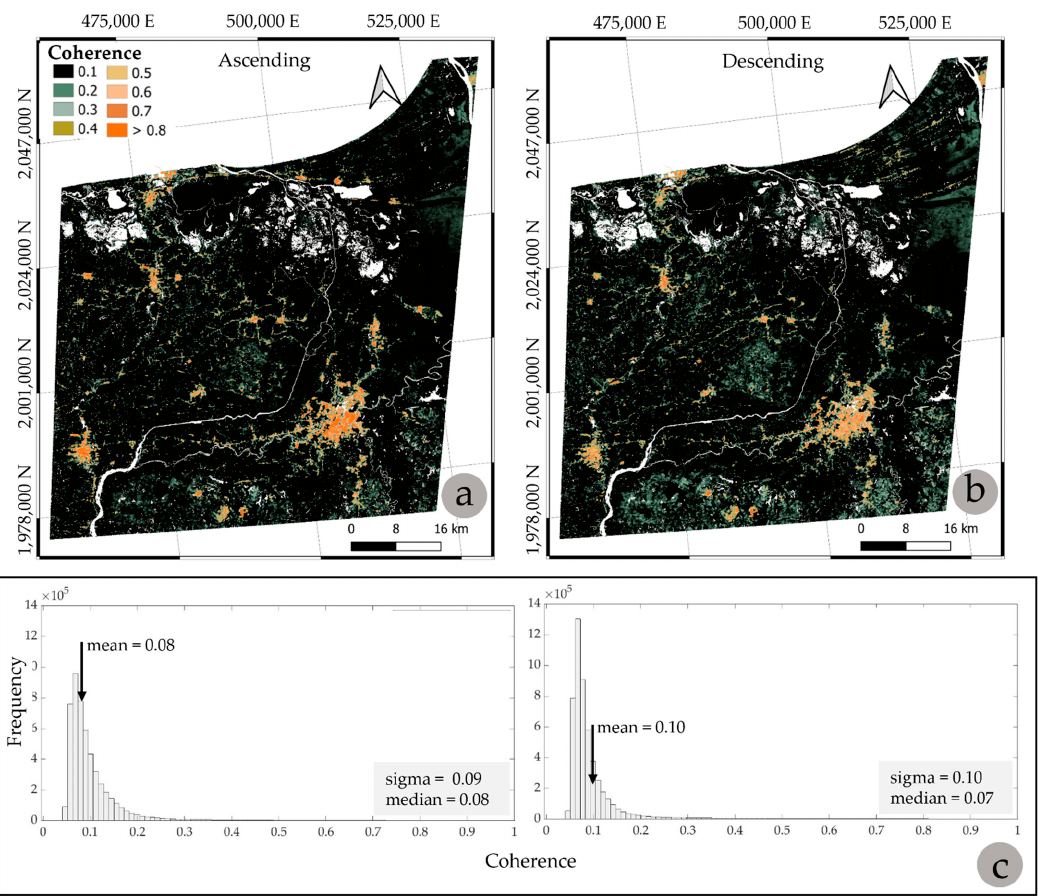
Figure 7. Average coherence estimated for the 2018–2019 period using image pairs from the ( a ) as- cending and ( b ) descending pass; ( c ) coherence histograms for each average coherence. Arrows indicate the mean coherence value.